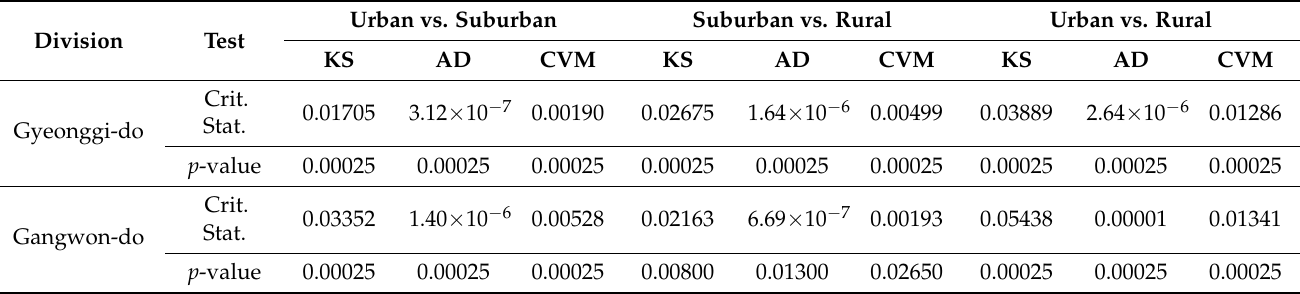
Figure 10. Annual average hourly traffic volume ratios to AADT (weekdays) of national highways of the urban, suburban, and rural areas: ( a ) Gyeonggi-do; ( b ) Gangwon-do. Table 9. Results of the two-sample goodness-of-fit tests (principal